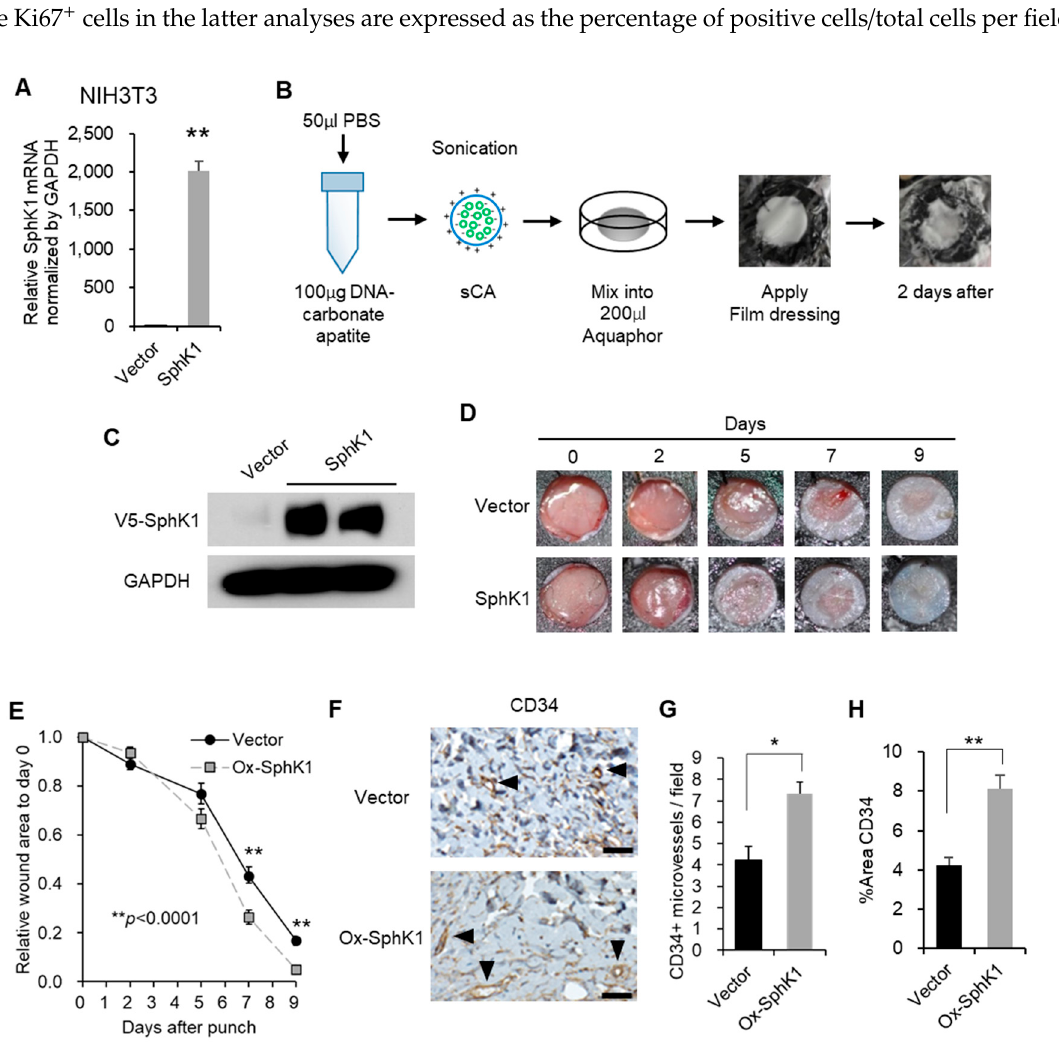
Figure 4. Effect of SphK1 overexpression on wound healing, vasculogenesis, and cell proliferation. ( A ) In vitro transfection efficiency with SphK1-expressing plasmid using super carbonate apatite (sCA) in NIH3T3 cells. ( B ) An ointment containing a SphK1-expressing plasmid encapsulated with sCA was prepared. ( C ) In vivo transfection efficiency of the sCA-encapsulated plasmid, as shown by immunoblots of V5-SphK1 expression in the wound surface tissues two days after application. ( D ) Representative images of the closing wounds are shown. ( E ) Effect of the plasmid ointment on wound closure. The change in wound area over time is graphed ( n = 12). ( F ) Representative images of CD34 expression on immunohistochemistry are shown. Arrowheads indicate positive findings (scale bars: 50 µm). ( G ) The numbers of CD34-positive microvessels per 200-fold magnified field are graphed ( n = 4). ( H ) The percentage of the wound area that is occupied by CD34 + cells is graphed ( n = 4). ( I ) Representative images of Ki67 expression in fibroblasts on immunohistochemistry are shown.